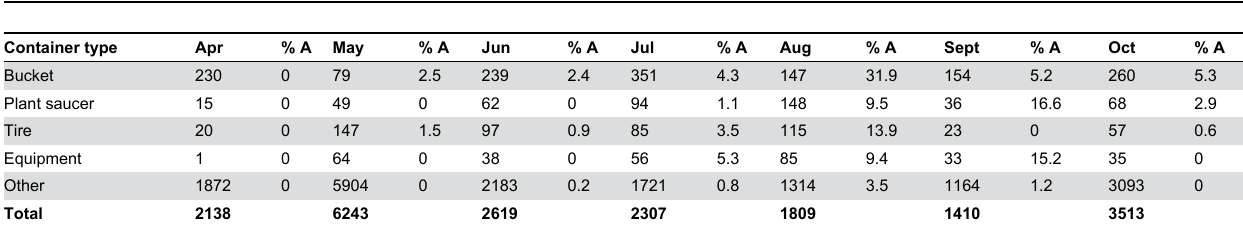
Table 2. Seasonal patterns of occurrence of containers defined as “key” for Ae. albopictus (the first 4 types) as well as a summary of abundance of other